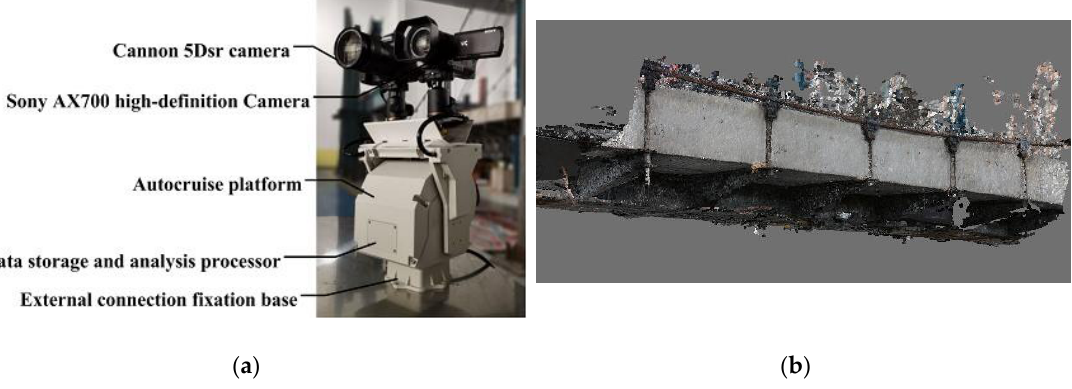
Figure 1. Holographic visual sensor: ( a ) main components of sensor; ( b ) holography geometric morphology of the structure.